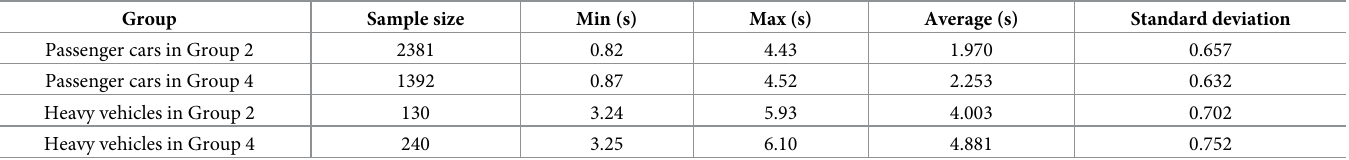
Table 4. Headway descriptive statistics in Group 2 and Group